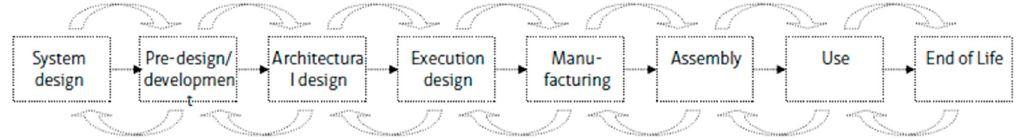
Figure 3. Design and construction phases of a curtain wall (Klein [34]; reprinted with permission: Klein).